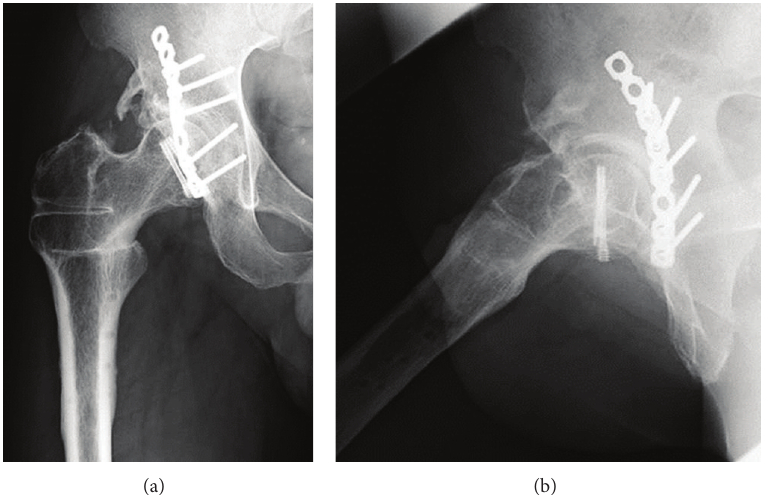
Figure 5: Case 1. (a) Anteroposterior X-ray image of the right hip at 3 years after osteotomy. (b) Lateral X-ray image of the right hip at 3 years after osteotomy.